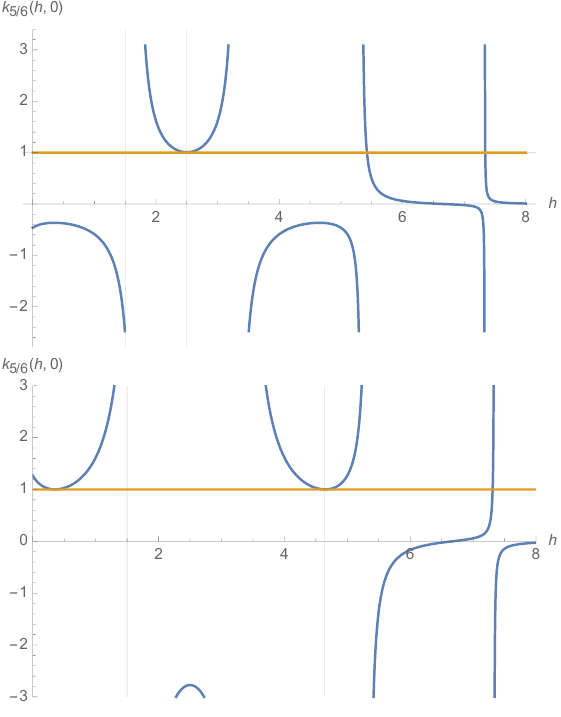
( h, 0) of the ladder-kernel in d = 5 , at the value g = 9 . 17 , Figure 5 . Left: the eigenvalues k 5 / 6 when the lowest conformal dimensions h merges with its shadow h at the value 5 / 2 . Right: 0 , 0 − 1 , 0 the merging of the h and h conformal dimensions, at g = i 15 . 2 . In both plots, the leftmost 0 , 0 1 , 0 vertical line (in light gray) represents the scalar unitarity bound 3 / 2 , while the rightmost one gives the value of h at the crossing ( 2 . 5 and 4 . 64